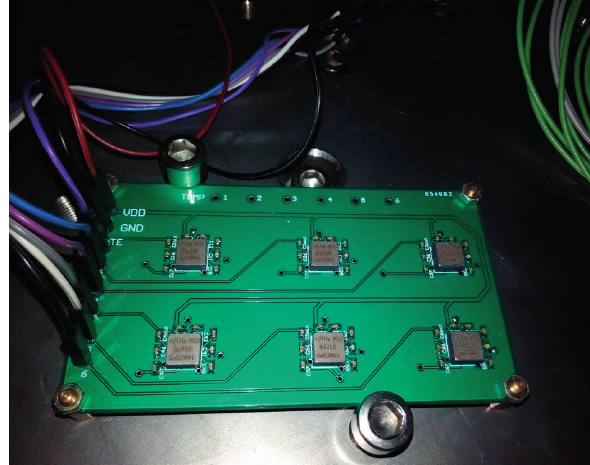
Figure 1. Prototype of the virtual gyroscope.